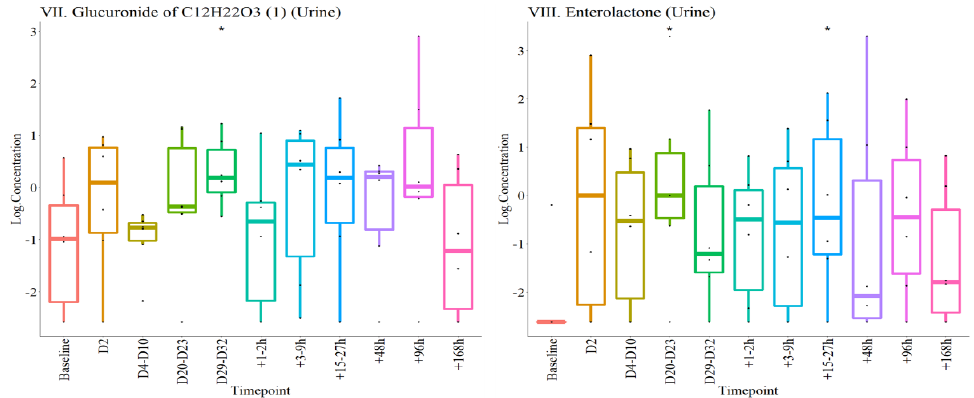
Figure 6. Concentrations of eight metabolites (four in serum and four in urine) altered at different time points before day 7 post-transfusion. The log concentrations at different time-points are plotted for each metabolite as labelled in I to VII1. * p < 0.05, ** p < 0.01, compared with baseline.